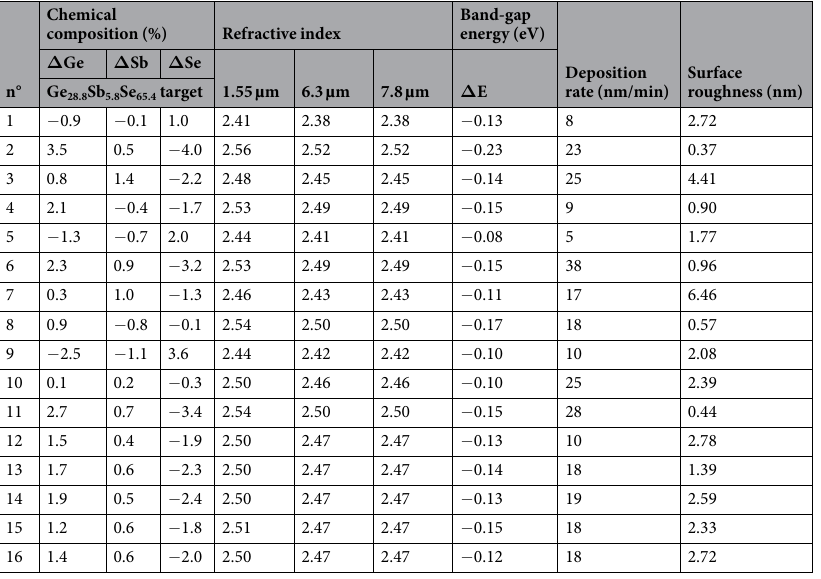
Table 3. Experimental results for the Ge 28.1 Sb 6.3 Se 65.6 thin films (chemical composition, refractive index, band- gap energy and surface roughness).